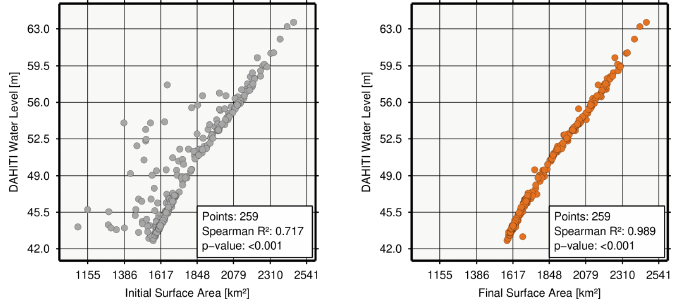
Figure 20. Validation of surface area time series for Tharthar Lake using water levels from satellite altimetry. The improvement of our new approach is shown by comparing initial surface areas with data gaps ( left ) and final filled surface areas ( right